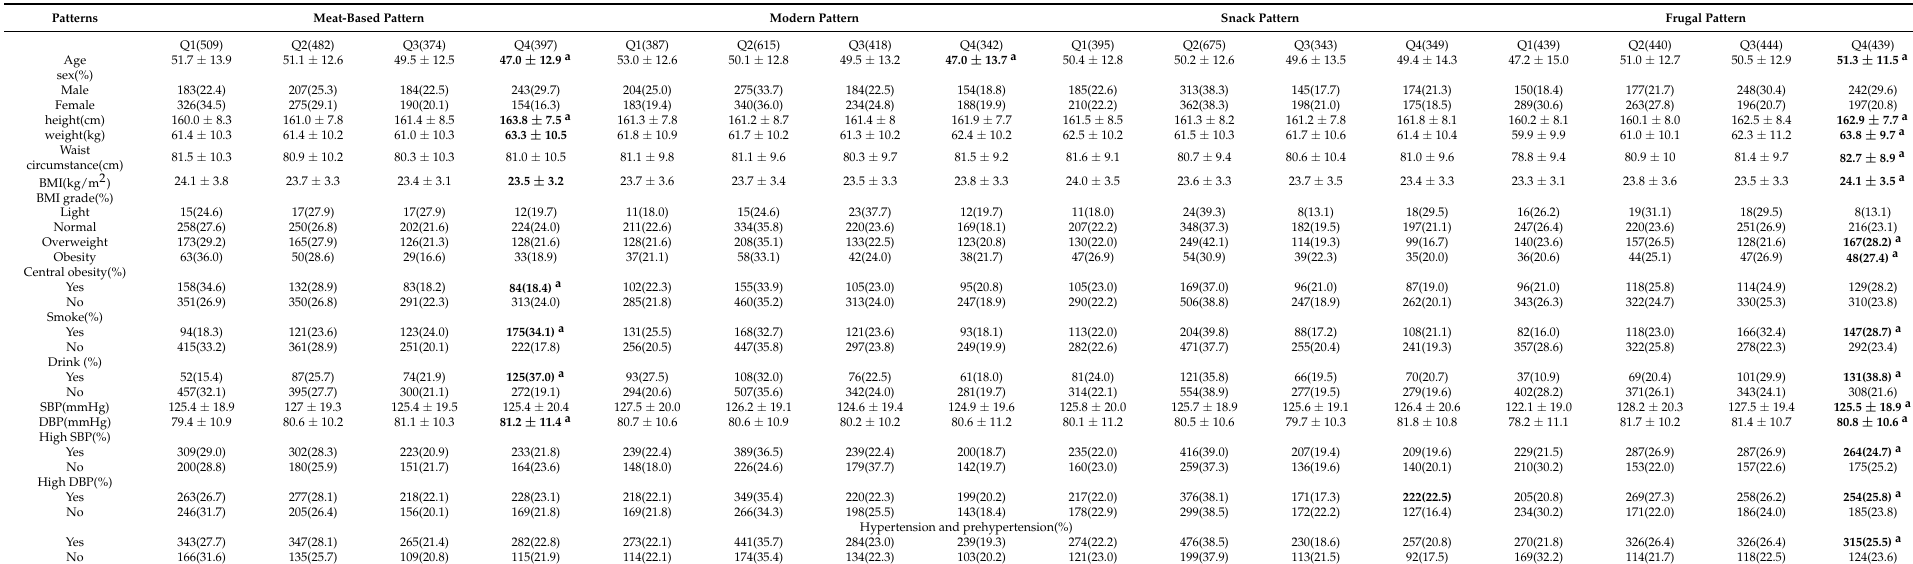
Table 2. Baseline characteristics of participants by quartiles of dietary patterns in the